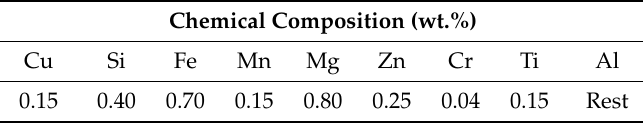
Table 2. Chemical composition of 6061-T6